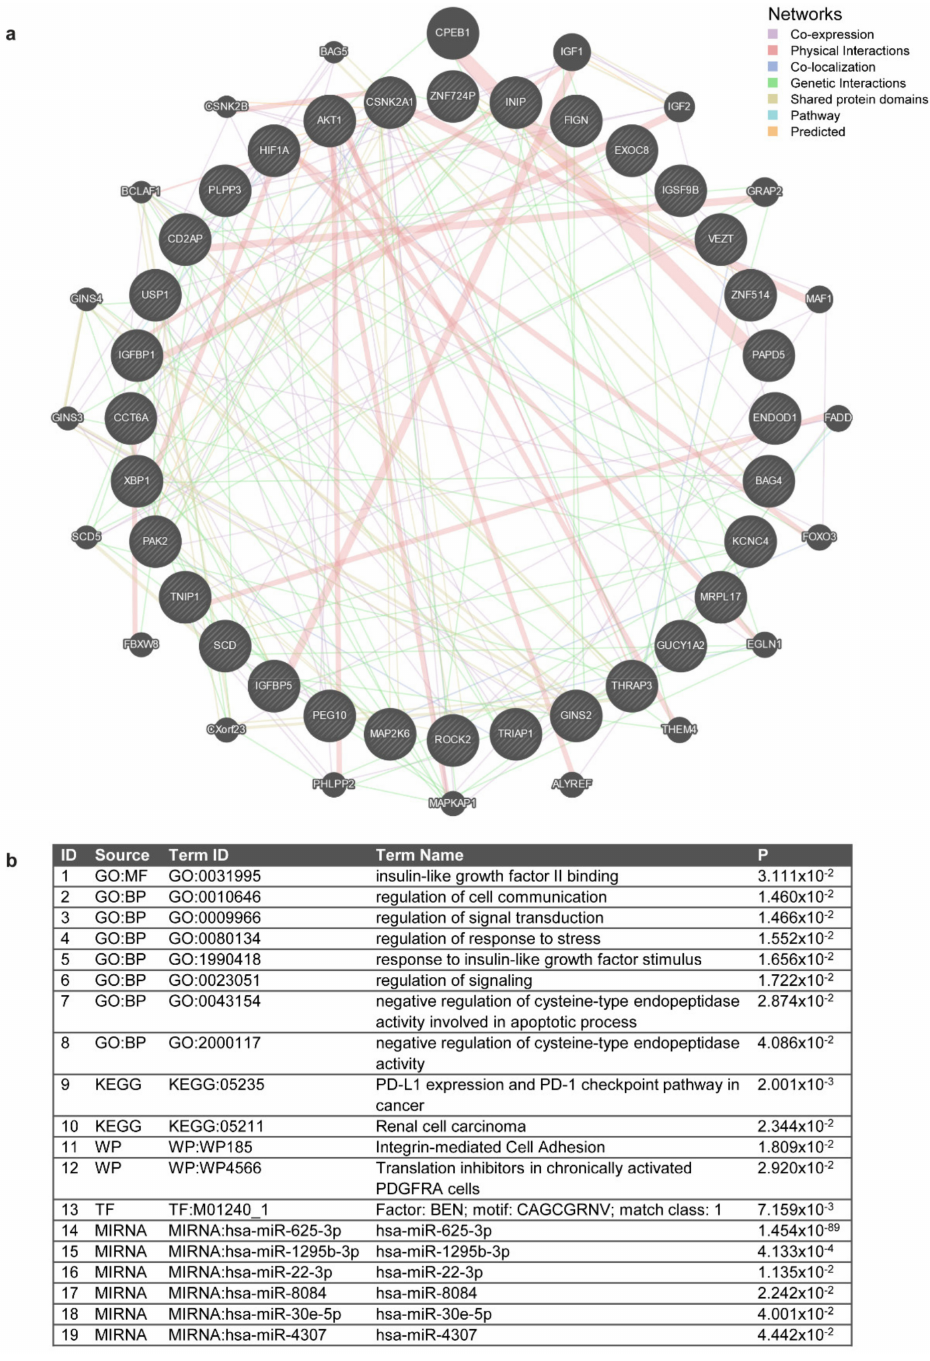
Figure 2. ( a ) Experimentally confirmed miR-625-3p targets and their interactions based on co- expression, physical interactions, co-localization, genetic interactions, shared protein domains, and predicted interactions. MiR-625-3p target genes are presented in the inner circle, while the outer circle shows other associated genes based on GeneMania analysis. Target gene c7orf65 was not included in GeneMania. ( b ) gProfiler pathway enrichment analysis: biological processes and pathways linked to miR-625-3p target genes, term names, codes and significance level. BP: biological process; GO: gene ontology; KEGG: Kyoto Encyclopedia of Genes and Genomes; MF: molecular function; TF: transcription factor; WP: